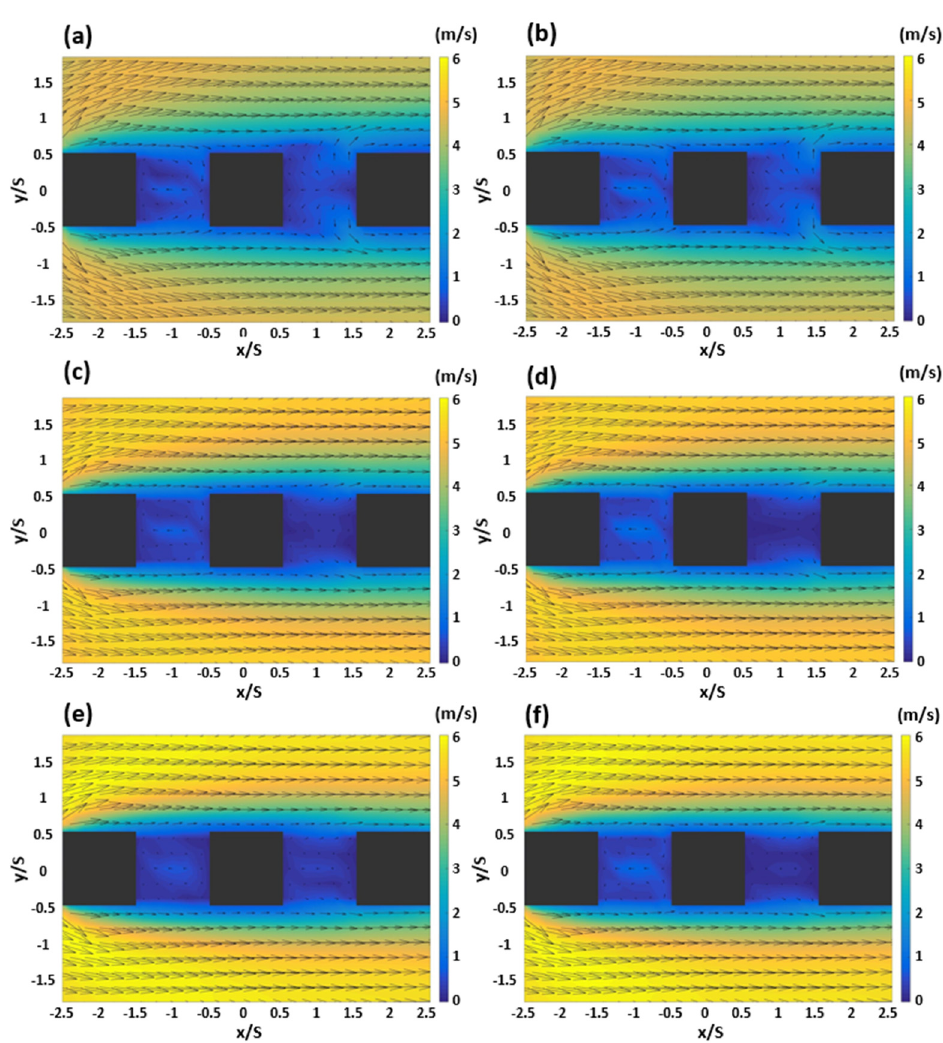
Figure 7. Wind field and wind speed of step-up to step-down (Case 1) in the shallow canyons (left panel) and deep canyons (right panel); ( a , b ) z/S = 0.2; ( c , d ) z/S = 0.6; ( e , f ) z/S = 1.0.